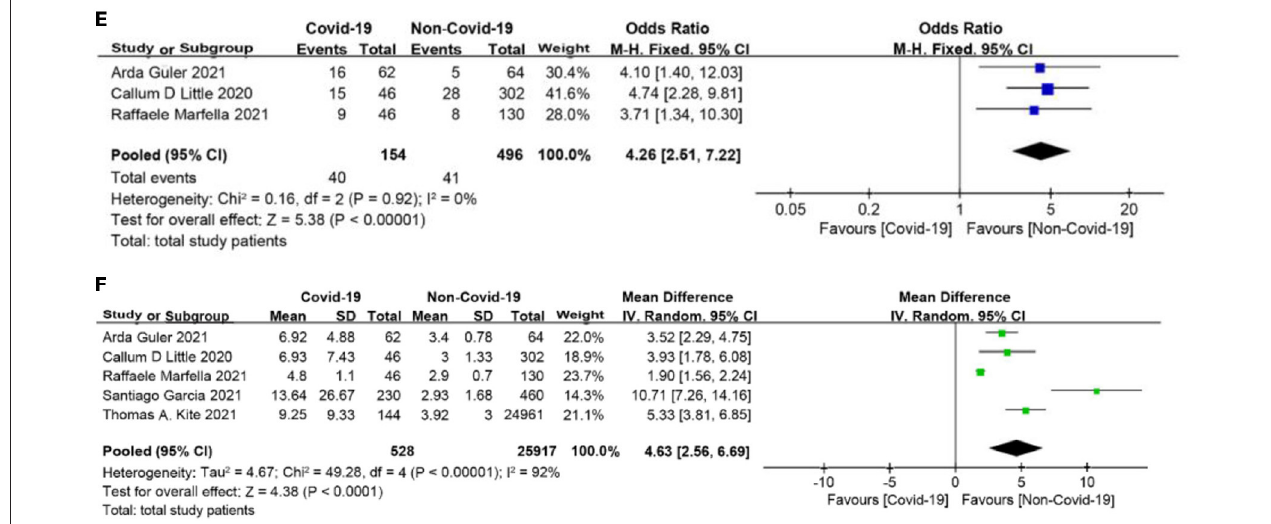
increased ICU admission rate and length of stay may have a significant impact on hospital resources.